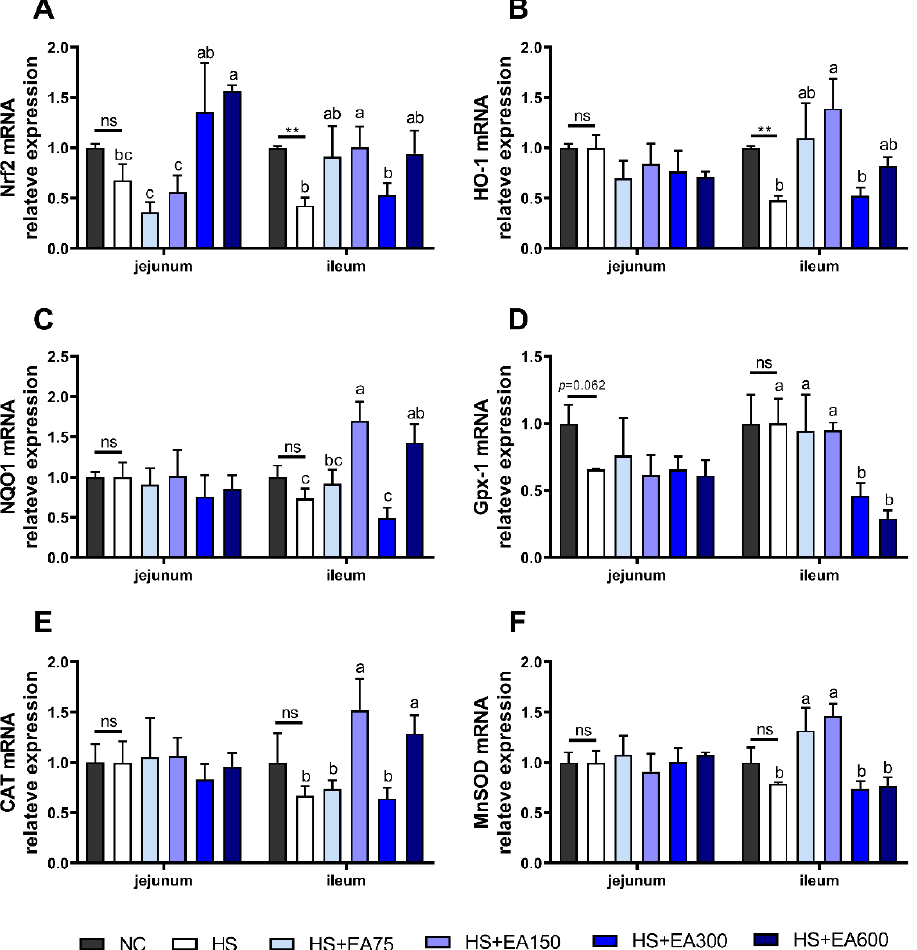
Figure 7. Effects of dietary EA on the mRNA levels involved in the antioxidant system in heat-stressed broilers. ( A ) Nrf2, nuclear factor-E2-related factor 2; ( B ) HO-1, heme oxygenase 1. ( C ) NQO1, NAD(P)H: quinone oxidoreductase. ( D ) GPx, glutathione peroxidase. ( E ) CAT, catalase. ( F ) MnSOD, manganese-containing superoxide dismutase. Data are presented as mean ± SEM (n = 6). NC (negative control) represents the broilers supplemented with a basal diet at normal temperature (23 ± 2 °C). The broilers in the 5 experimental groups were supplemented with basal diets containing different levels of EA (0, 75, 150, 300, and 600 mg/kg) at HS temperature (35 ± 2 °C), which are represented as HS, HS + EA75, HS + EA150, HS +EA300, and HS + EA600, respectively. Shared superscript letters indicate no significant difference where p > 0.05. “**” indicates a significant difference between groups where p < 0.01. “ns” indicates a no significant difference between groups where p > 0.05.